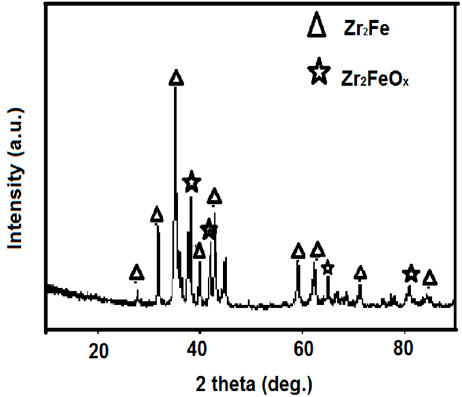
Figure 1. X-ray power di ff raction (XRD) pattern of Zr 2 Fe alloy.